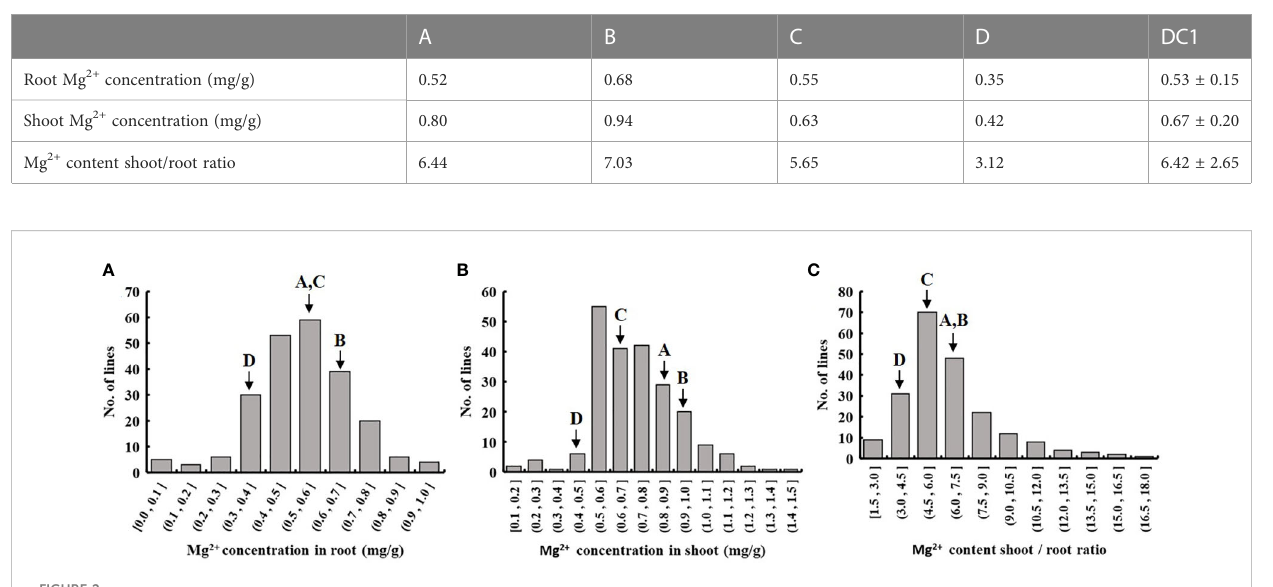
FIGURE 2 Frequency distribution of Mg 2+ uptake and translocation traits in the DC1 population. Rice seedlings of the MAGIC population in the 1/4 strength IRRI solution for two weeks, and in the full strength IRRI solution without Mg 2+ for three weeks. Frequency distribution of (A) root Mg 2+ concentration, (B) shoot Mg 2+ concentration and (C) shoot-to-root ratio of Mg 2+ content. A, B, C and D represent the parental lines A, B, C and